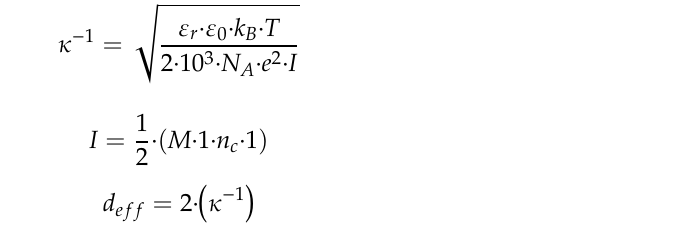
Table 3. Comparison of surface tension and evaporation rate of CUP